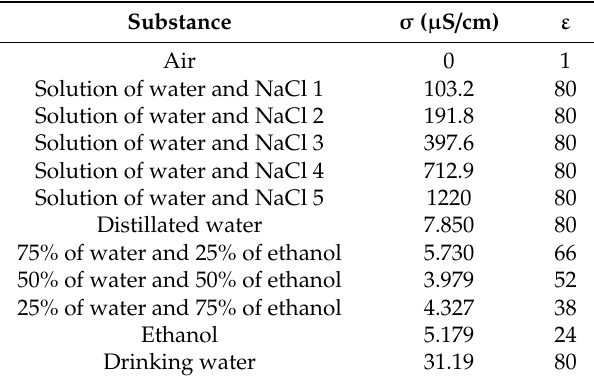
Table 1. Substances used in the calibration process.